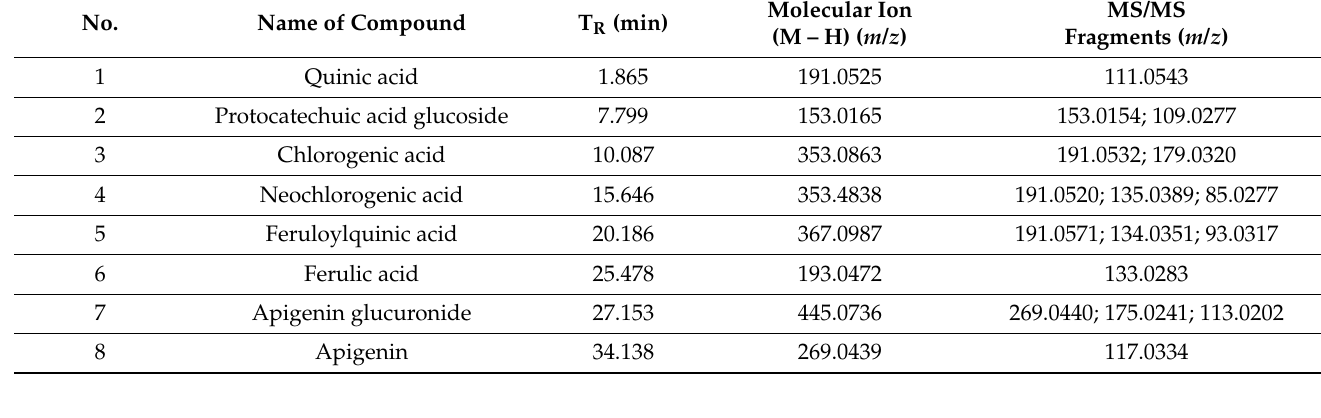
Table 3. CAS H 2 O extract. Fragmentation analysis of identified compounds by LC/(-)ESI–QTOF–MS.